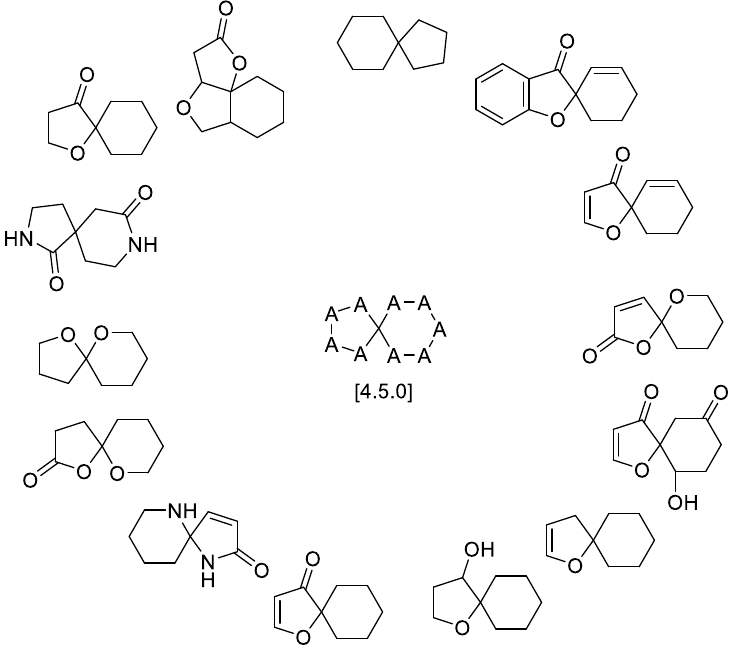
Figure 58. Current diversity of [4.5.0] spirocyclic scaffolds.